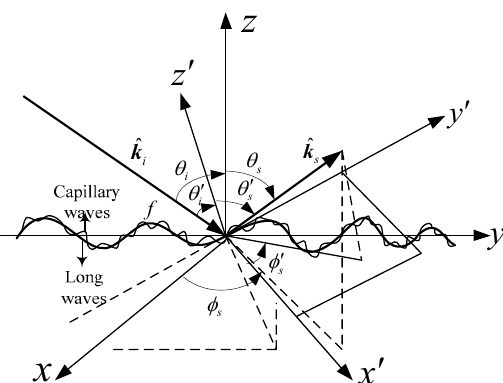
Figure 1. Illustration of electromagnetic (EM) scattering from an electrically large oceanic surface.